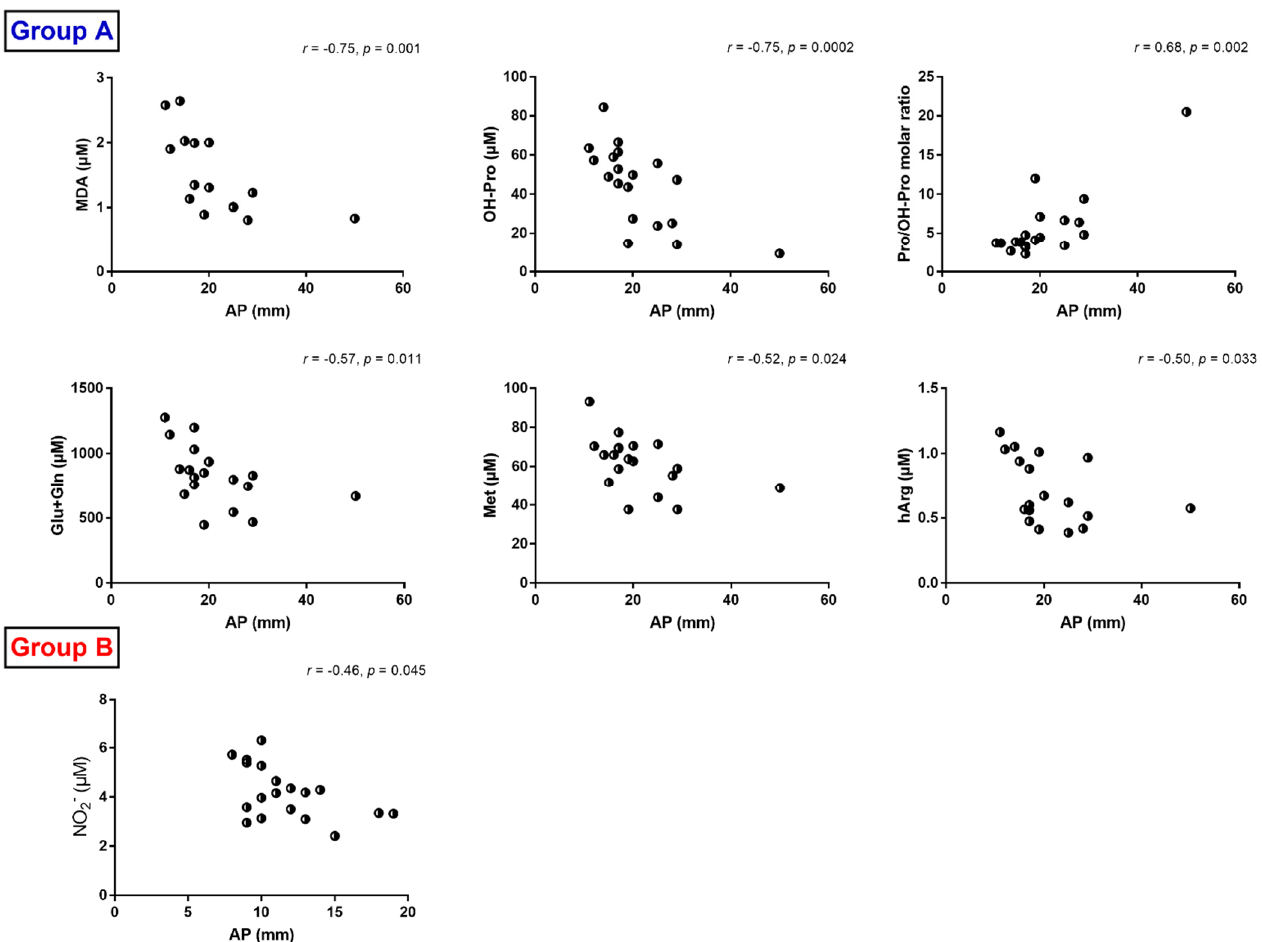
Figure 5. Illustration of statistically significant correlations ( r > 0.4, p < 0.05) found between AP diameter and serum concentration of the indicated metabolites in Group A (surgical treatment) and Group B (conservative treatment). Spearman correlation was performed in all comparisons.